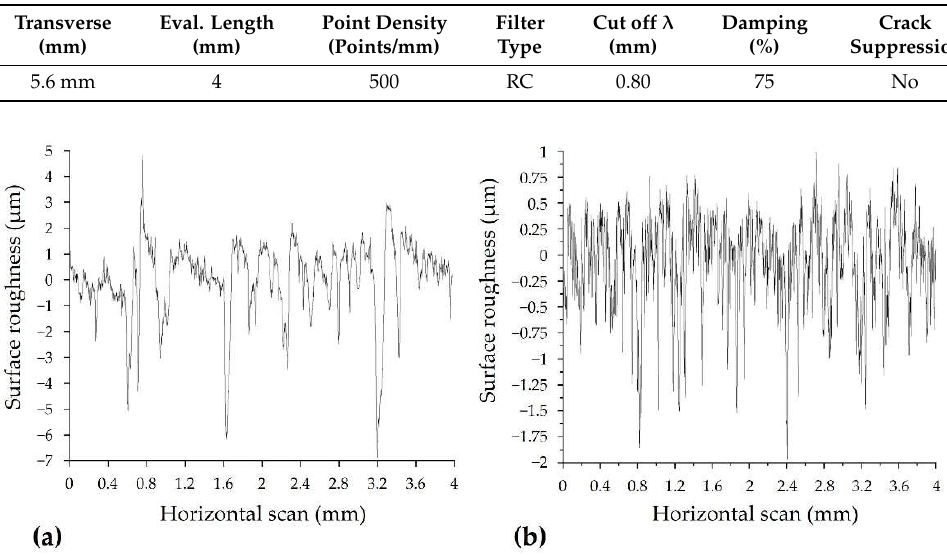
Table 2. Optical profilometry filter parameters.